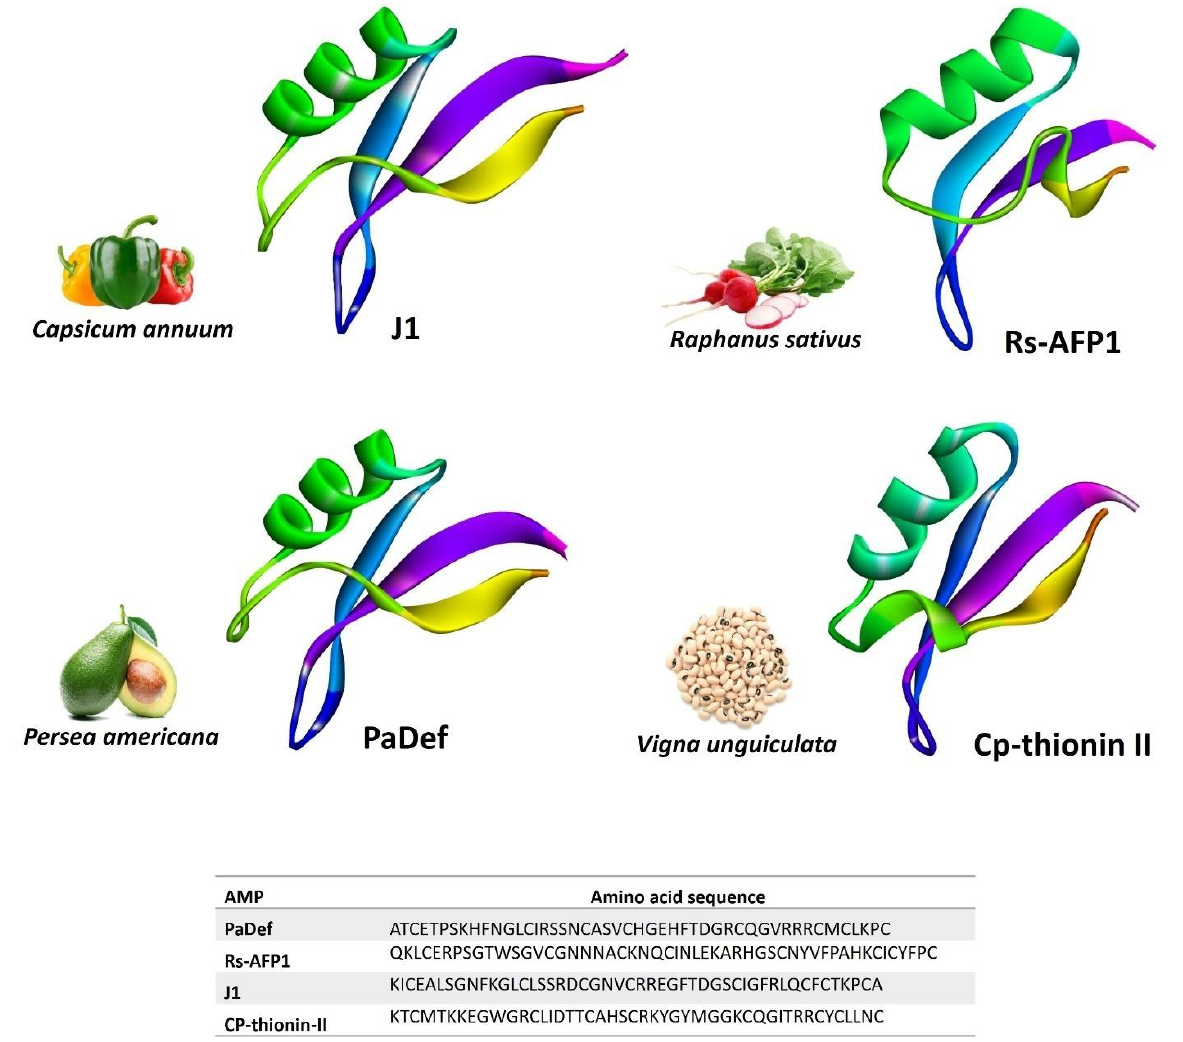
Figure 1. Selected plant defensins that showed potential antimicrobial activities for food preservation: J1 (predicted in this study), Rs-AFP1 (PDB ID: 1AYJ), PaDef (predicted in this study), and Cp-thionin II (predicted in this study). Predicted structures are modeled via homology modeling using the Swiss model (https://swissmodel.expasy.org accessed on 30 July 2022).